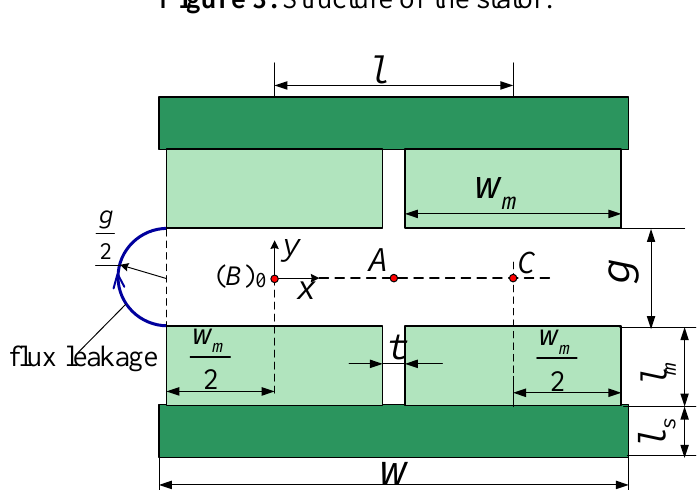
Figure 3. Structure of the